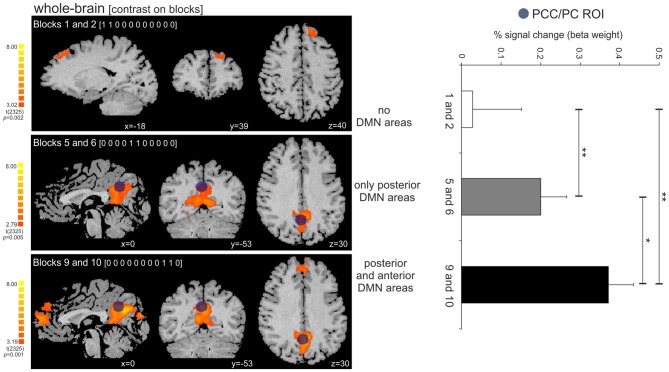
Activity increase in the PCC/PC ROI across the three tested time-points (beginning, middle and end of the periodic task). (Left panel) Dark blue circle on top of the statistical maps depicts the location of the PCC/PC ROI used for the three contrasts. The contrasts on the periodic motion blocks revealed clusters in the superior frontal cortex (BA 8; blocks 1 and 2), PCC/PC (blocks 5 and 6; blocks 9 and 10), and DMPFC/ACC (blocks 9 and 10). (Right panel) The activity in the PCC/PC ROI significantly increased across the three blocks. *p = 0.01; **p < 0.005.